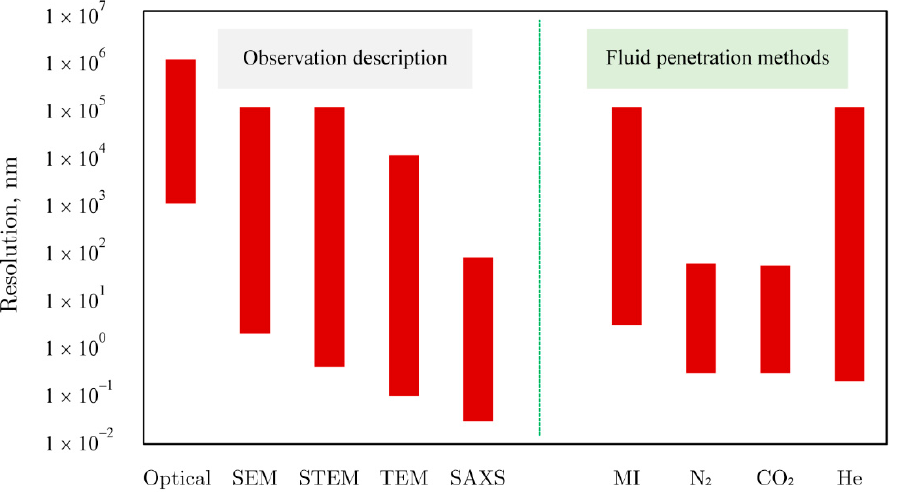
Figure 2. The resolution of different methods to characterize micropore structures [2–4].